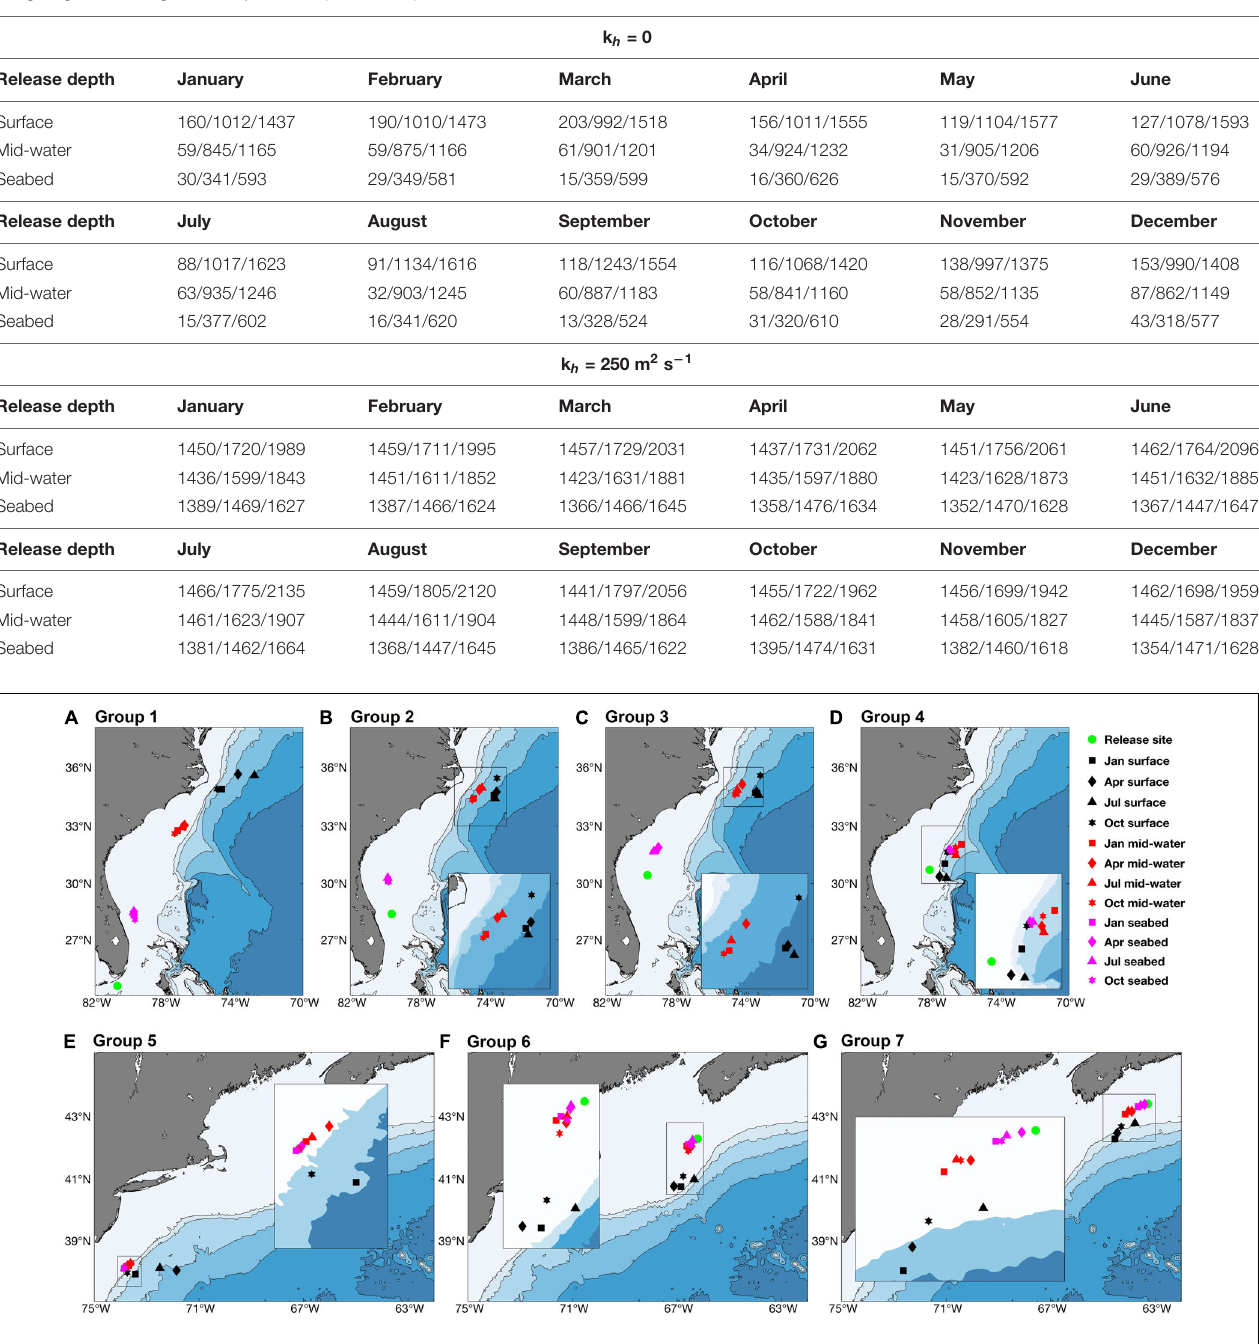
FIGURE 3 | Mean ending positions of particles released at each of three depths in January, April, July, or October using long-term averaged currents in release sites from (A) Group 1, (B) Group 2, (C) Group 3, (D) Group 4, (E) Group 5, (F) Group 6, and (G) Group 7, modeled with k h = 0. (For results from modeling with k h = 250 m 2 s − 1 , see Supplementary Figure 2 .) Filled green circles denote mean release position of particles in the Group.